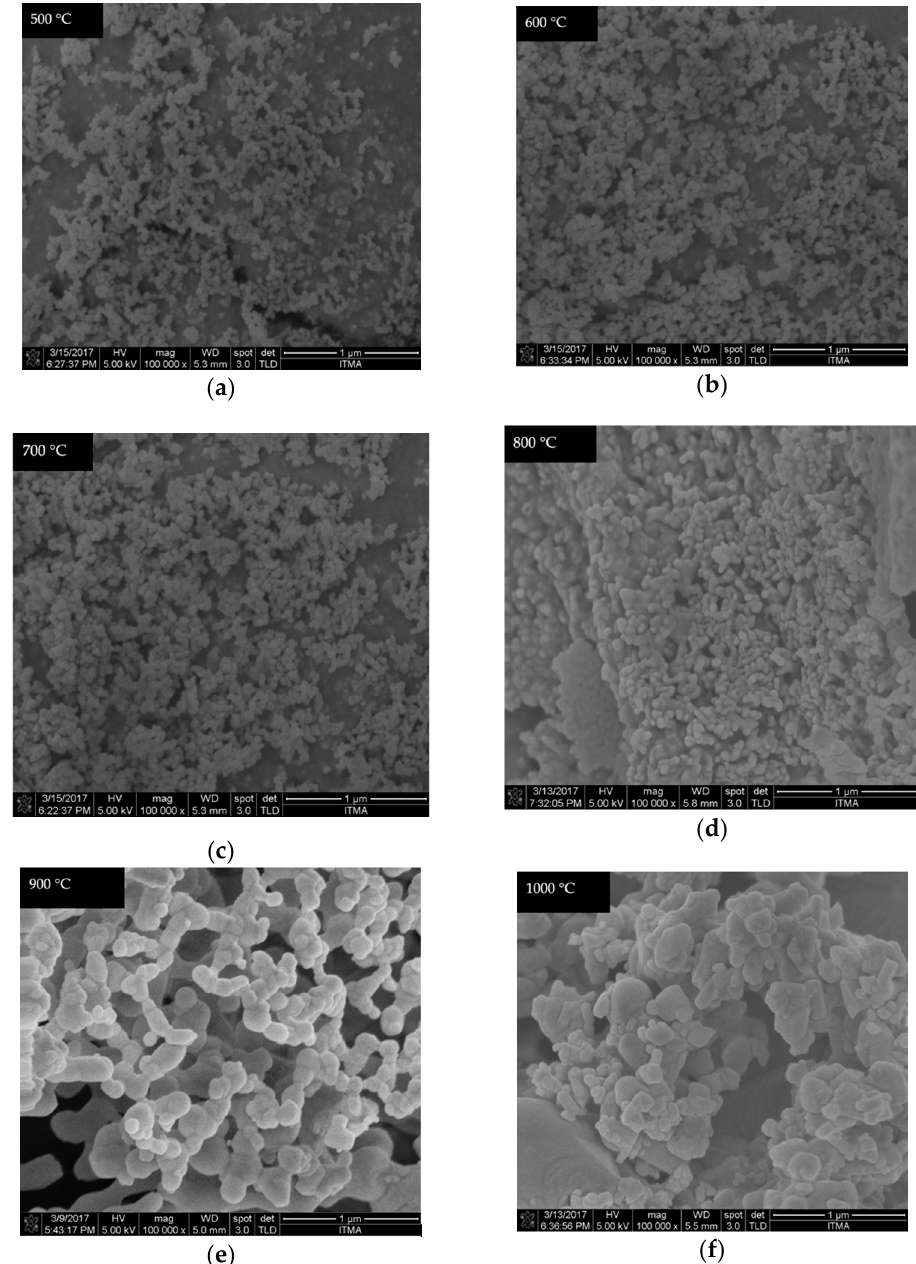
Figure 11. FESEM micrographs of the undoped willemite NPs calcined at different